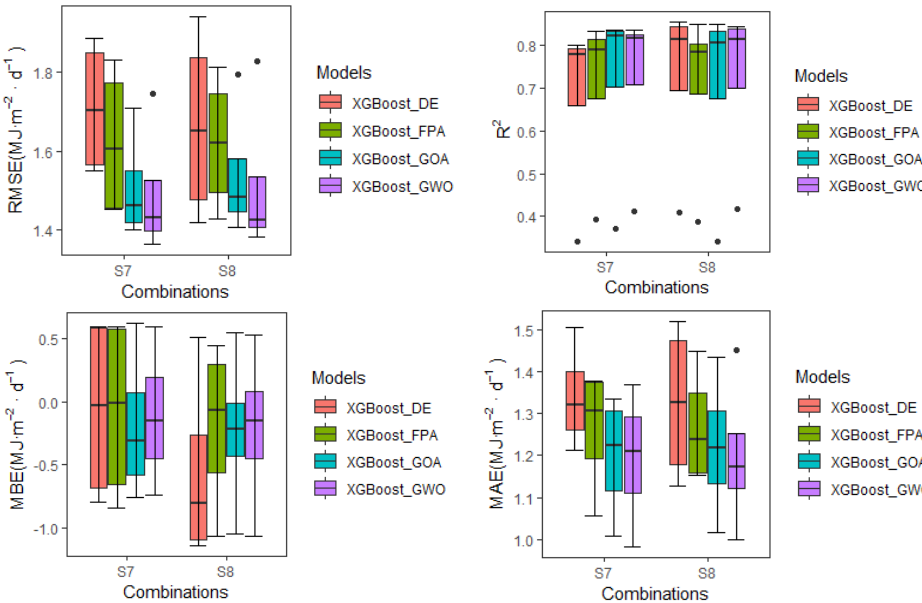
Figure 7. Boxplot of statistical indicators for the prediction of R d predicted by the coupling models based on Himawari-7 data at other stations in cross-station application.